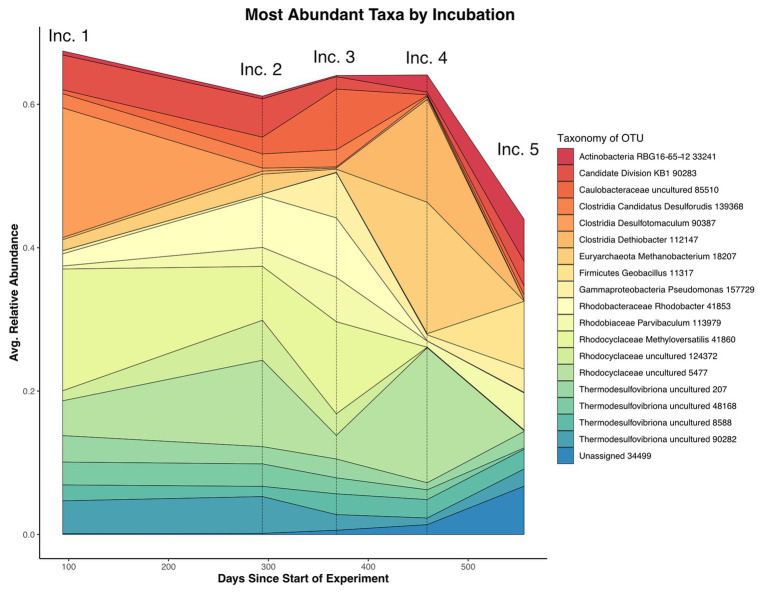
Average relative abundance of most abundant taxa by days since the start of the experiment, with individual incubation collection points noted above. The relative abundance as measured by 16S rRNA iTag data from mineral substrates common to all incubations was averaged at each time point. The data demonstrate the large relative abundance decrease in the Desulfotomaculum OTU co-occurent with the loss of framboidal iron sulfides in Incubation 2 as well as the large bloom in a Methanobacter OTU in Incubation 4 (6 months after organic substrate amendment). Incubation 5 displays a general increase in the proportion of rare taxa relative to the whole.